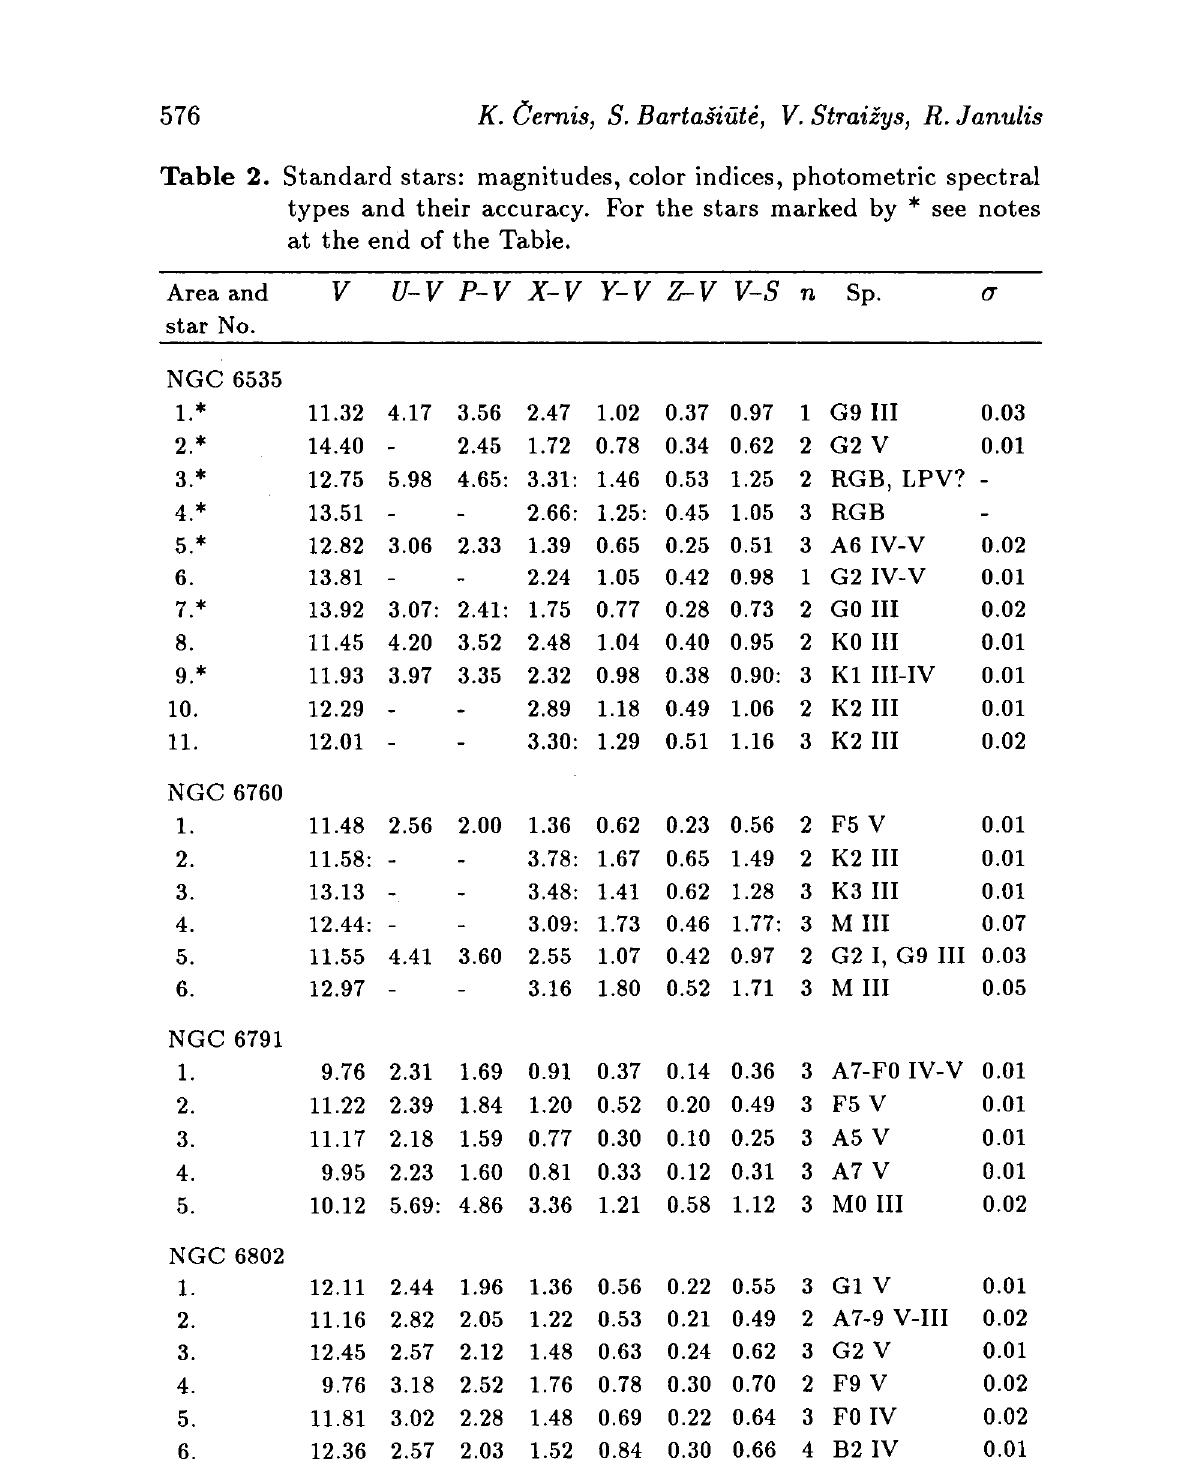
Table 2. Standard stars: magnitudes, color indices, photometric spectral types and their accuracy. For the stars marked by * see notes at the end of the Table. Area and star